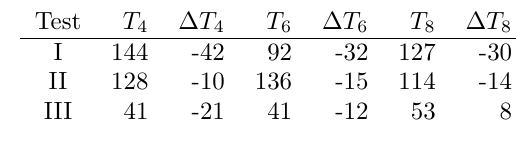
Figure 10: Thrust response per propeller, Test Case III. Top: 4 Actuators, Middle: 6 Actuators, Bottom: 8 Actuators. Blue: Input, Red: Acceleration, Green: Deceleration, Black: Simulation model. The circles represent the thrust at the 63% rise time.